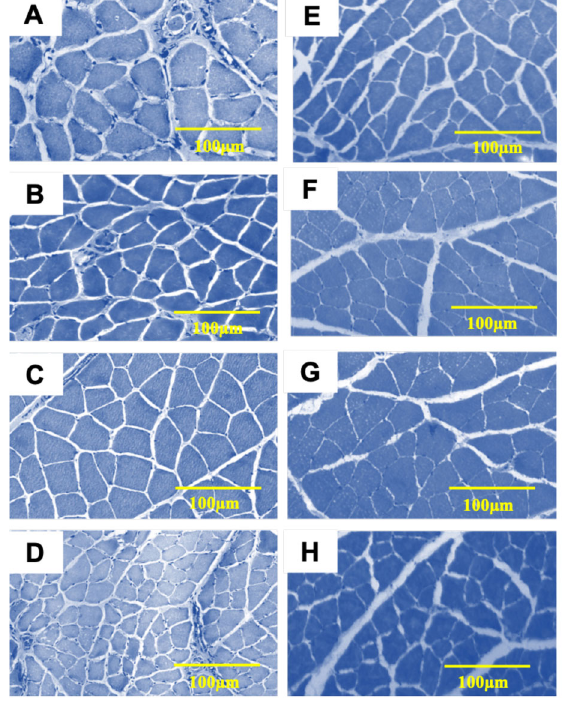
Figure 4. Comparison between triceps ( A ), biceps ( B ), fi nger fl exor ( C ), and fi nger extensor ( D ) muscles of the control group and the same muscles in the diabetes mellitus group ( E , F , G , H ). Scale bar: 100 m